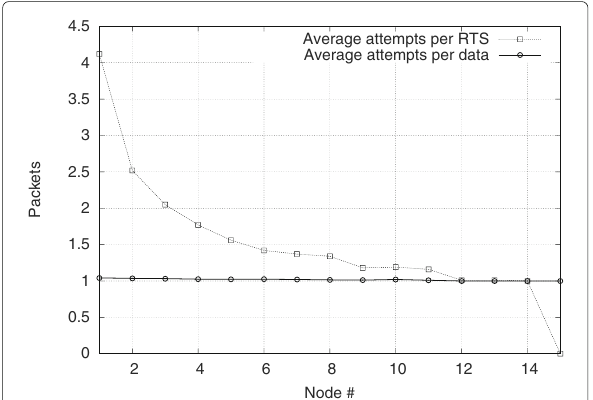
Fig. 2 Average number of attempts per RTS and data packets